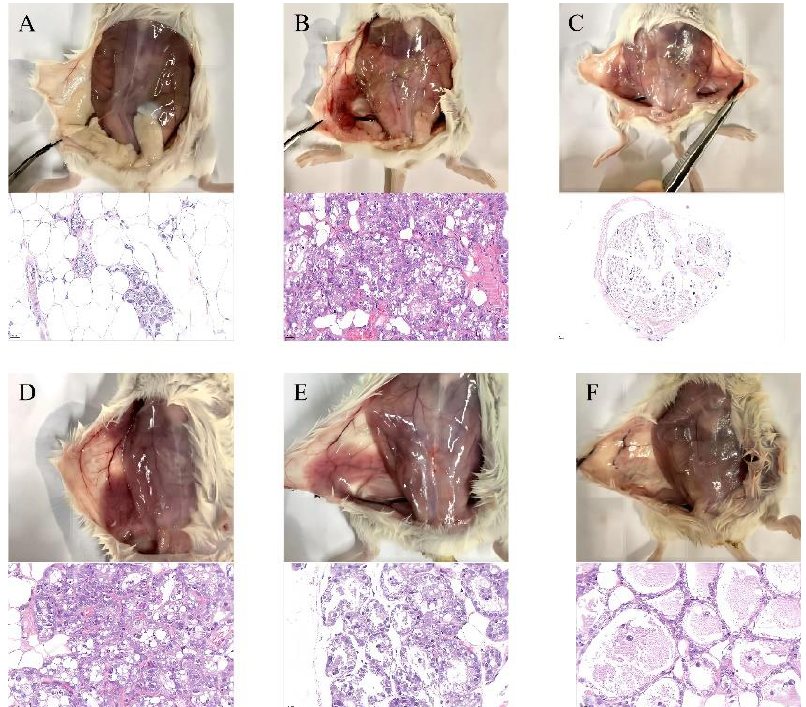
Figure 5. SG alleviated LPS-induced mammary gland injury in mice (HE; scale bar: 50 µm). ( A ) Control group. ( B ) LPS group. ( C ) LPS + dexamethasone group. ( D – F ) LPS + SG groups (5, 25, and 50 µM).